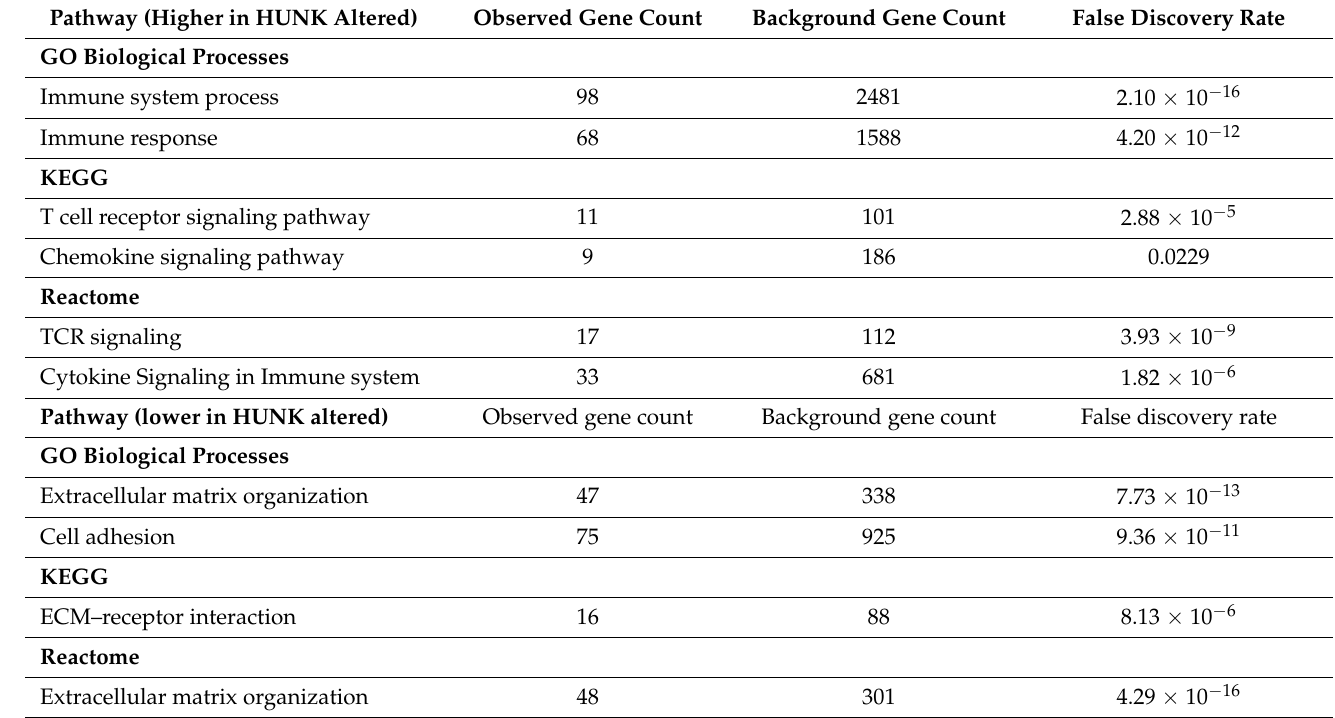
Table 2. Proteome analysis: Factors that were over-represented in the HUNK altered group assessed using GO Biological Processes, KEGG, and Reactome databases that were consolidated by the STRING